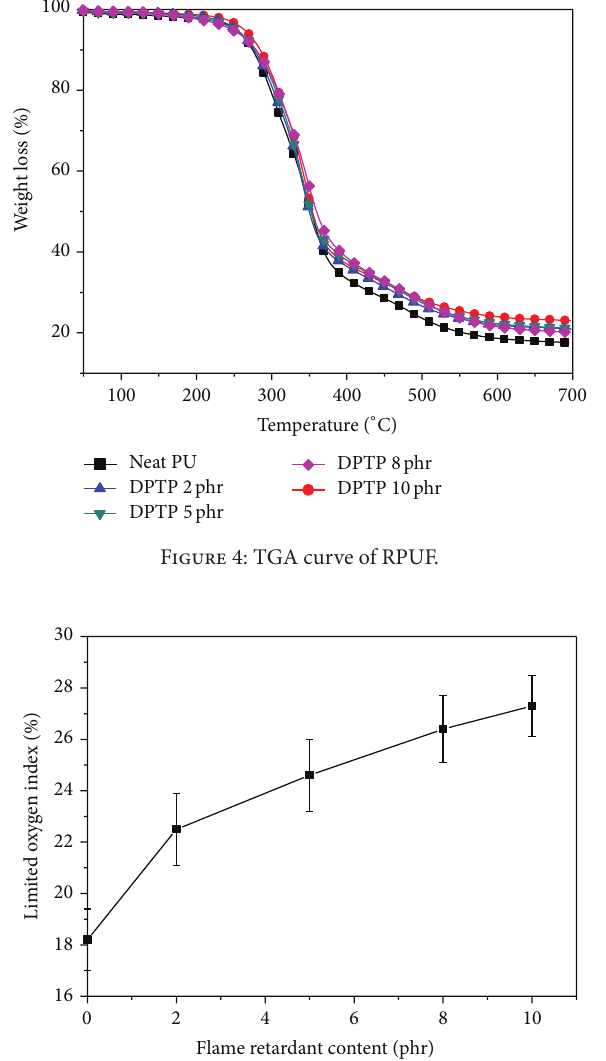
Figure 5: LOI values of DPTP flame-retardant RPUF composites.